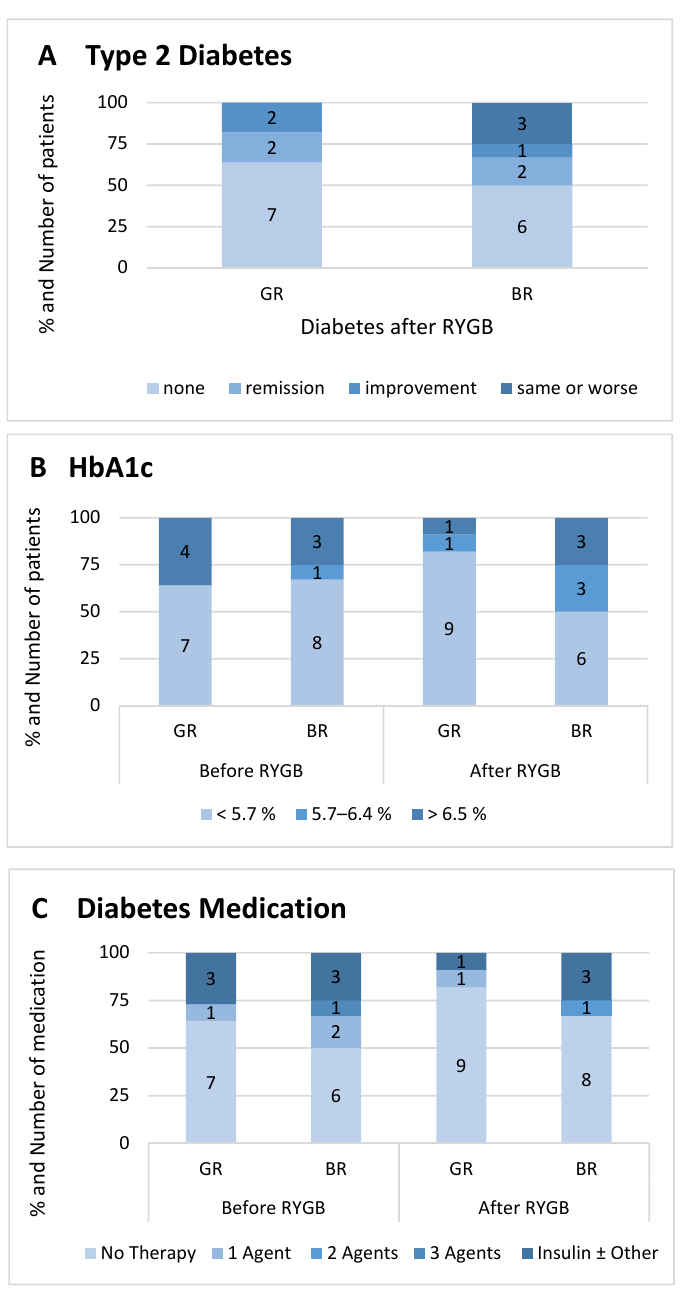
Figure 1. Relative and absolute proportion of patients in our cohort with and without (pre)diabetes. ( A ) Type 2 diabetes prevalence and remission status of both responder groups at follow up. ( B ) Hemoglobin A1c level independent of diabetes medication before RYGB intervention and at follow up. ( C ) Antidiabetic medication before RYGB intervention and at follow up. BR, bad responder group; GR, good responder group; HbA1c, hemoglobin A1c; RYGB, Roux ‐ en ‐ Y gastric bypass.